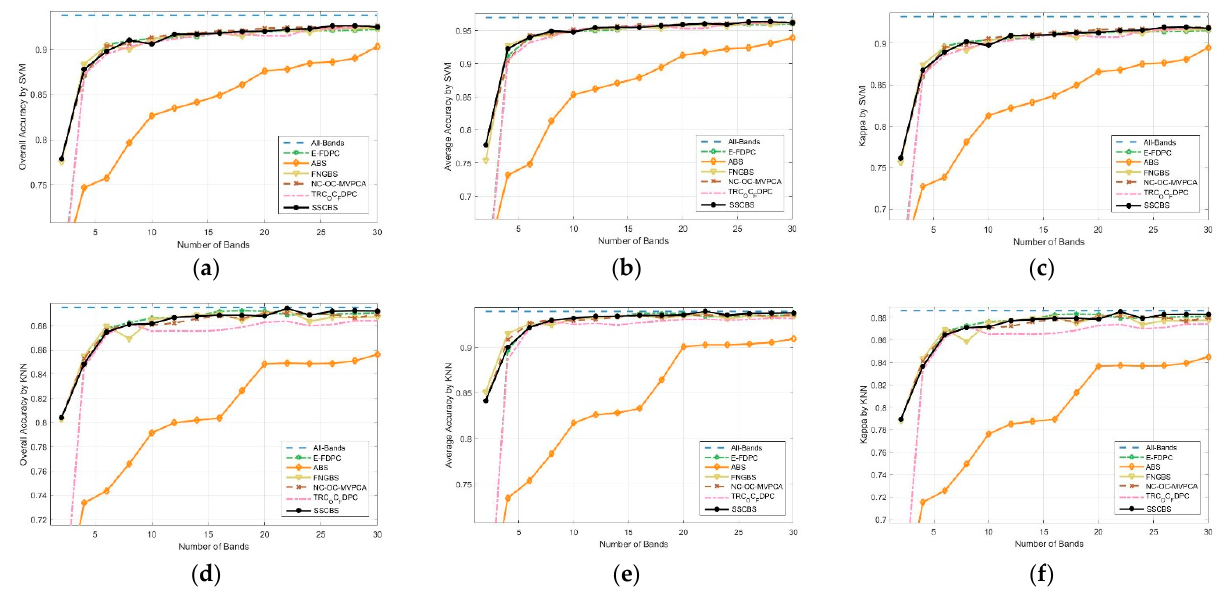
Figure 11. Classification results on Indian Pines data set. ( a – i ) are OA, AA and Kappa Results by SVM, KNN and LDA classifiers.